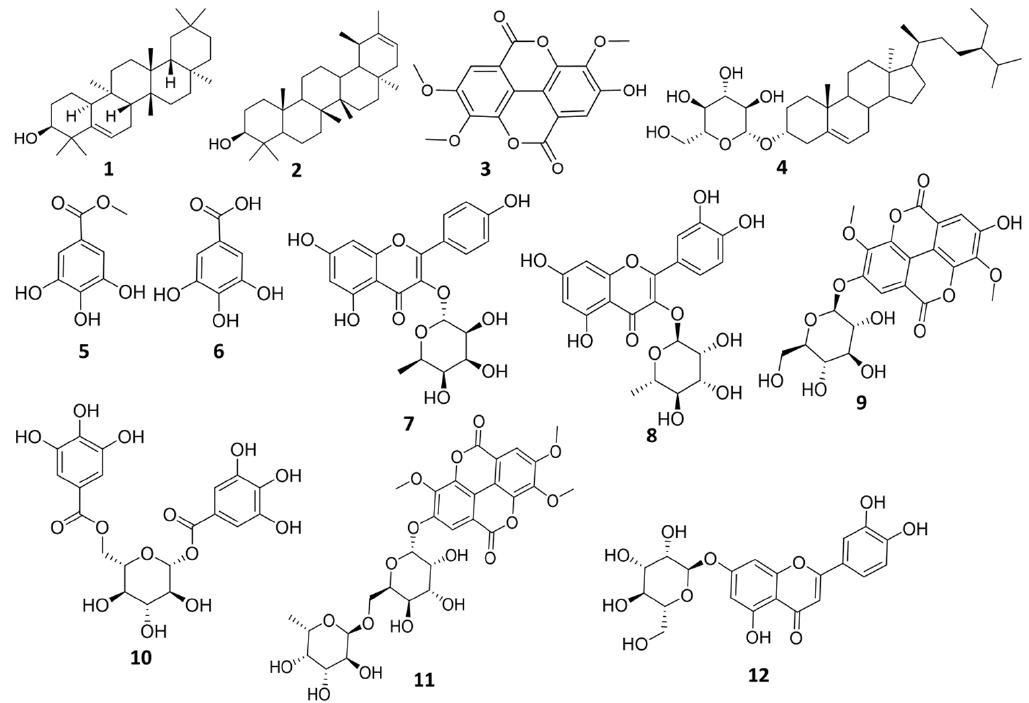
Figure 1. Structure of the isolated compounds from E. abyssinica.